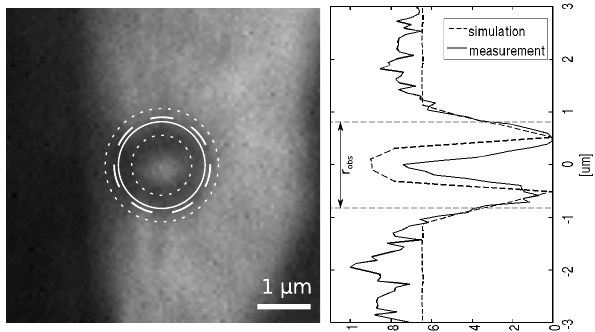
Figure 7. Photomicrograph of a vapour bubble taken at 5.1 ◦ C in a fluid inclusion from M1. The solid circle indicates the measured bubble size r obs , together with its margins of error ( ± 0.25µm, dot- ted lines). The circumference corresponding to the theoretical ra- dius r calc is shown as a white dashed circle. The right side shows the measured radial intensity profile compared with the simulation as well as the physical bubble boundary r obs